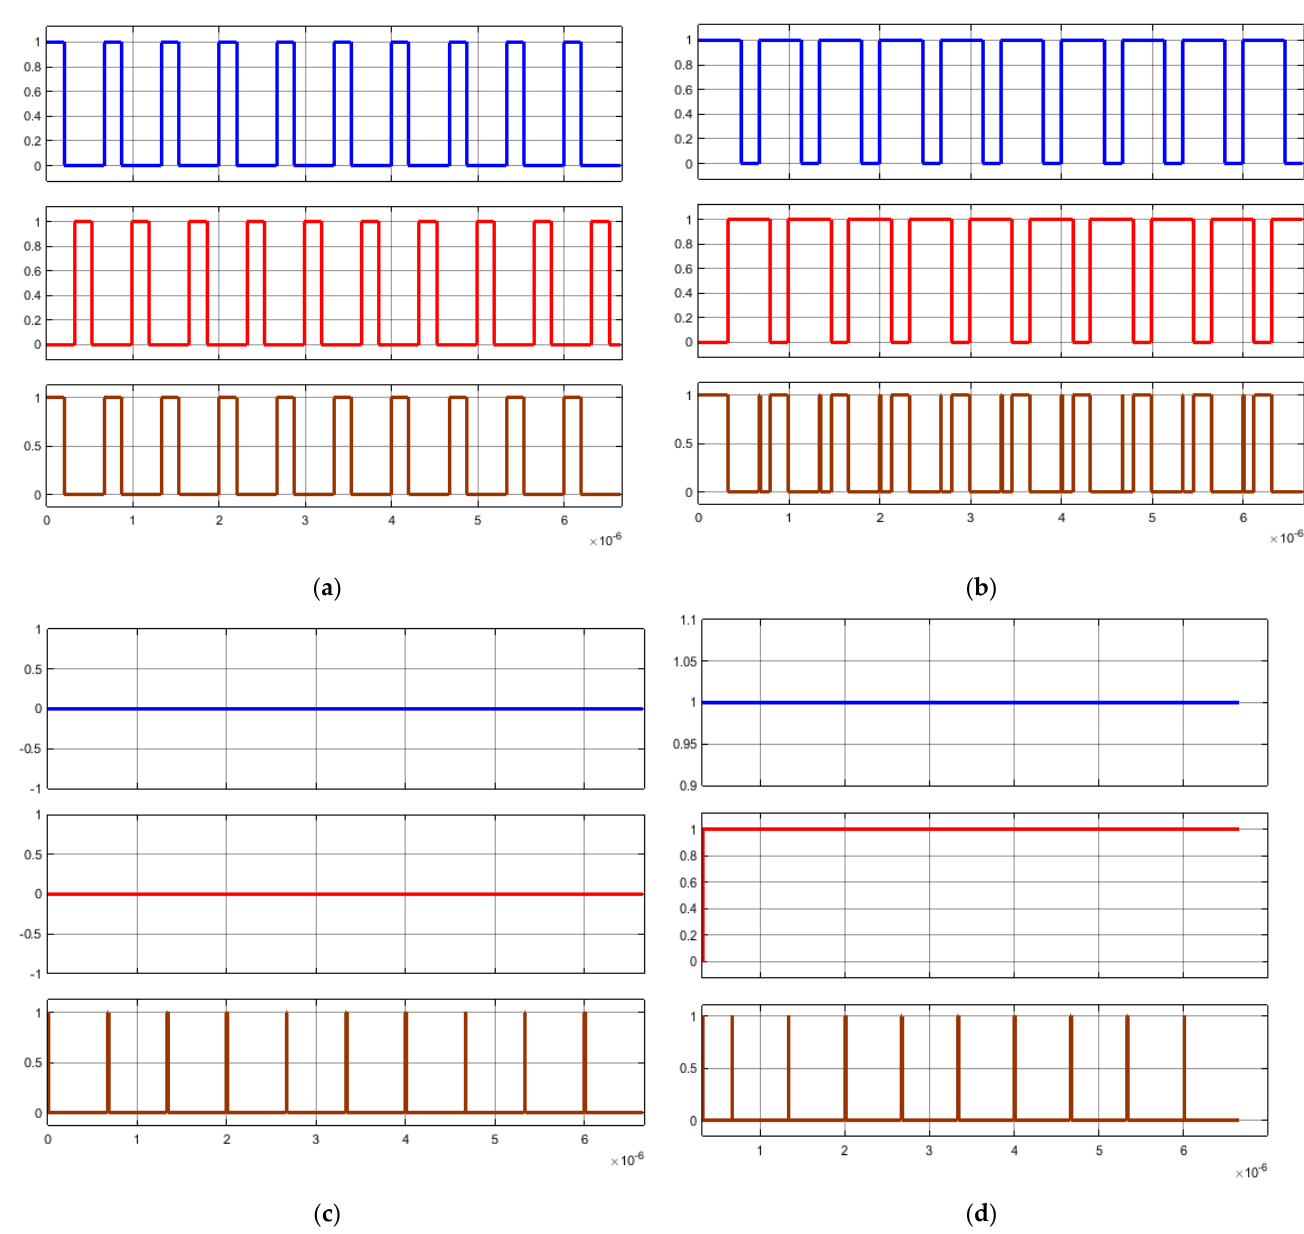
Figure 3. First-stage detection process: ( a ) A 1.5 MHz 30% actual duty PWM pulse (upper-blue), its 48% pulse-duration delayed counterpart (middle-red) and resultant first-stage voter output PWM pulse (lower-brown); ( b ) a faulty 1.5 MHz 70% duty (larger than the maximum duty, max-duty = 48%), PWM pulse (upper-blue), its 48% pulse-duration delayed counterpart (middle-red) and resultant first-stage voter output PWM pulse (lower-brown); ( c ) a faulty 1.5 MHz 0% duty (stuck at logic-low fault), PWM pulse (upper-blue), its 48% pulse-duration delayed counterpart (middle-red) and resultant first-stage voter output PWM pulse (lower-brown); ( d ) a faulty 1.5 MHz 100% duty (stuck at logic-high fault), PWM pulse (upper-blue), its 48% pulse-duration delayed counterpart (middle-red) and resultant first-stage voter output PWM pulse (lower-brown).